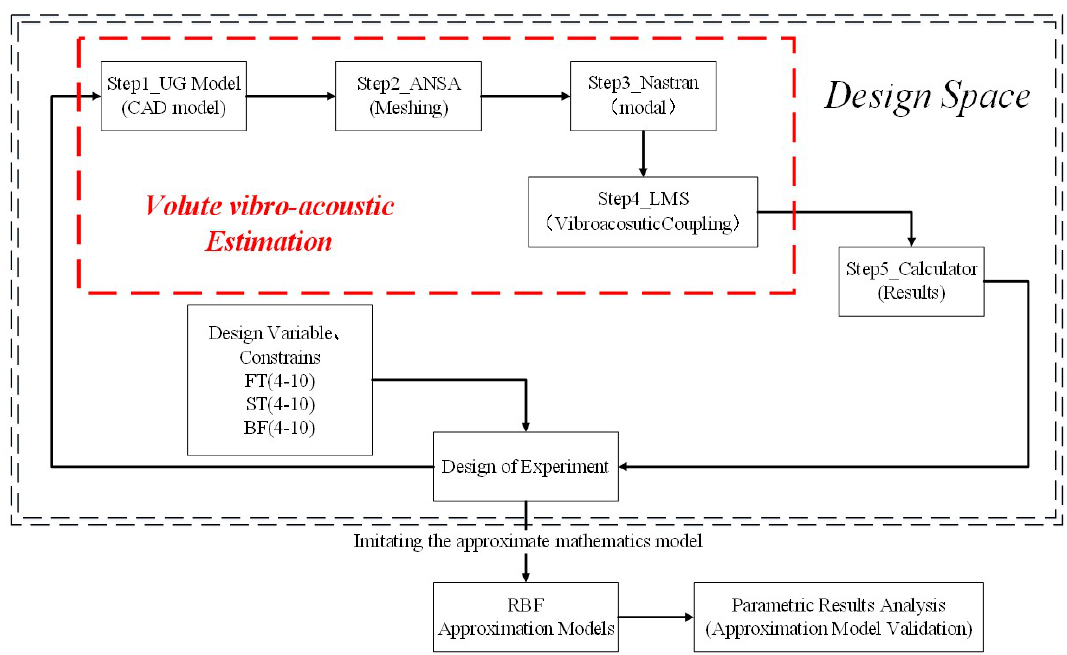
Figure 20. Design space and radial basis function (RBF) approximation model processing for optimization.